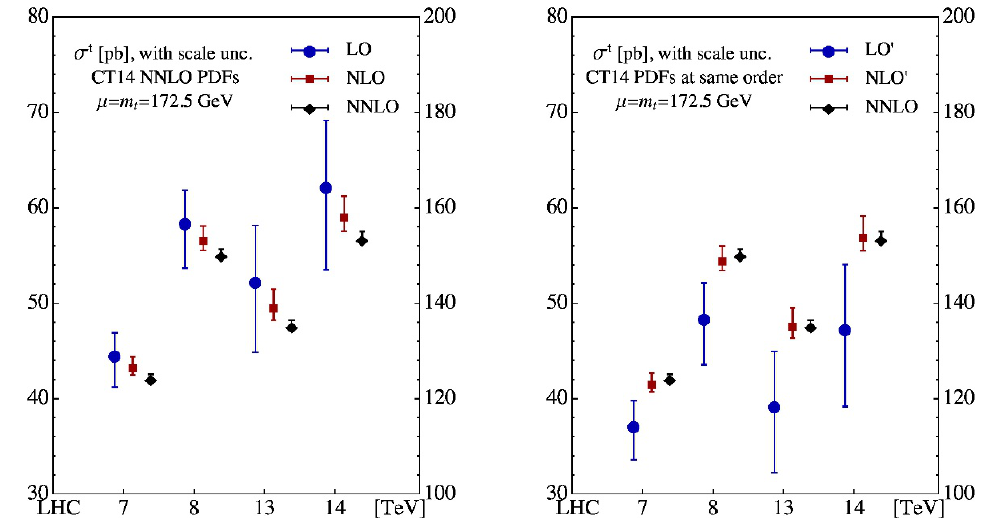
Figure 12 . Inclusive cross sections for t -channel single top quark production at LO, NLO and NNLO with CT14 NNLO PDFs (left) and CT14 PDFs at same order (right), at the LHC with di(cid:11)erent center of mass energies. Error bars represent scale uncertainties obtained by varying the renormalization and factorization scale from (cid:22)